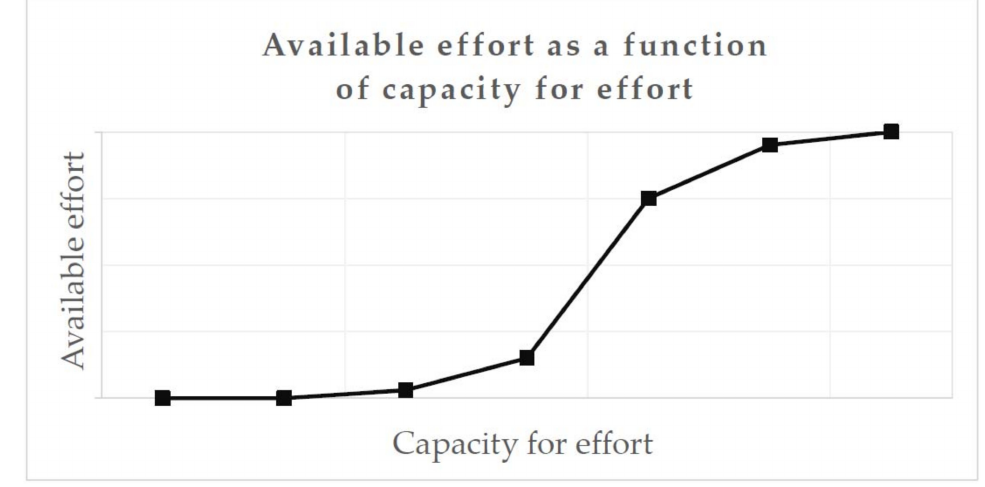
Figure 3. Example of a nonlinear function—available e ff ort as a function of capacity for e ff